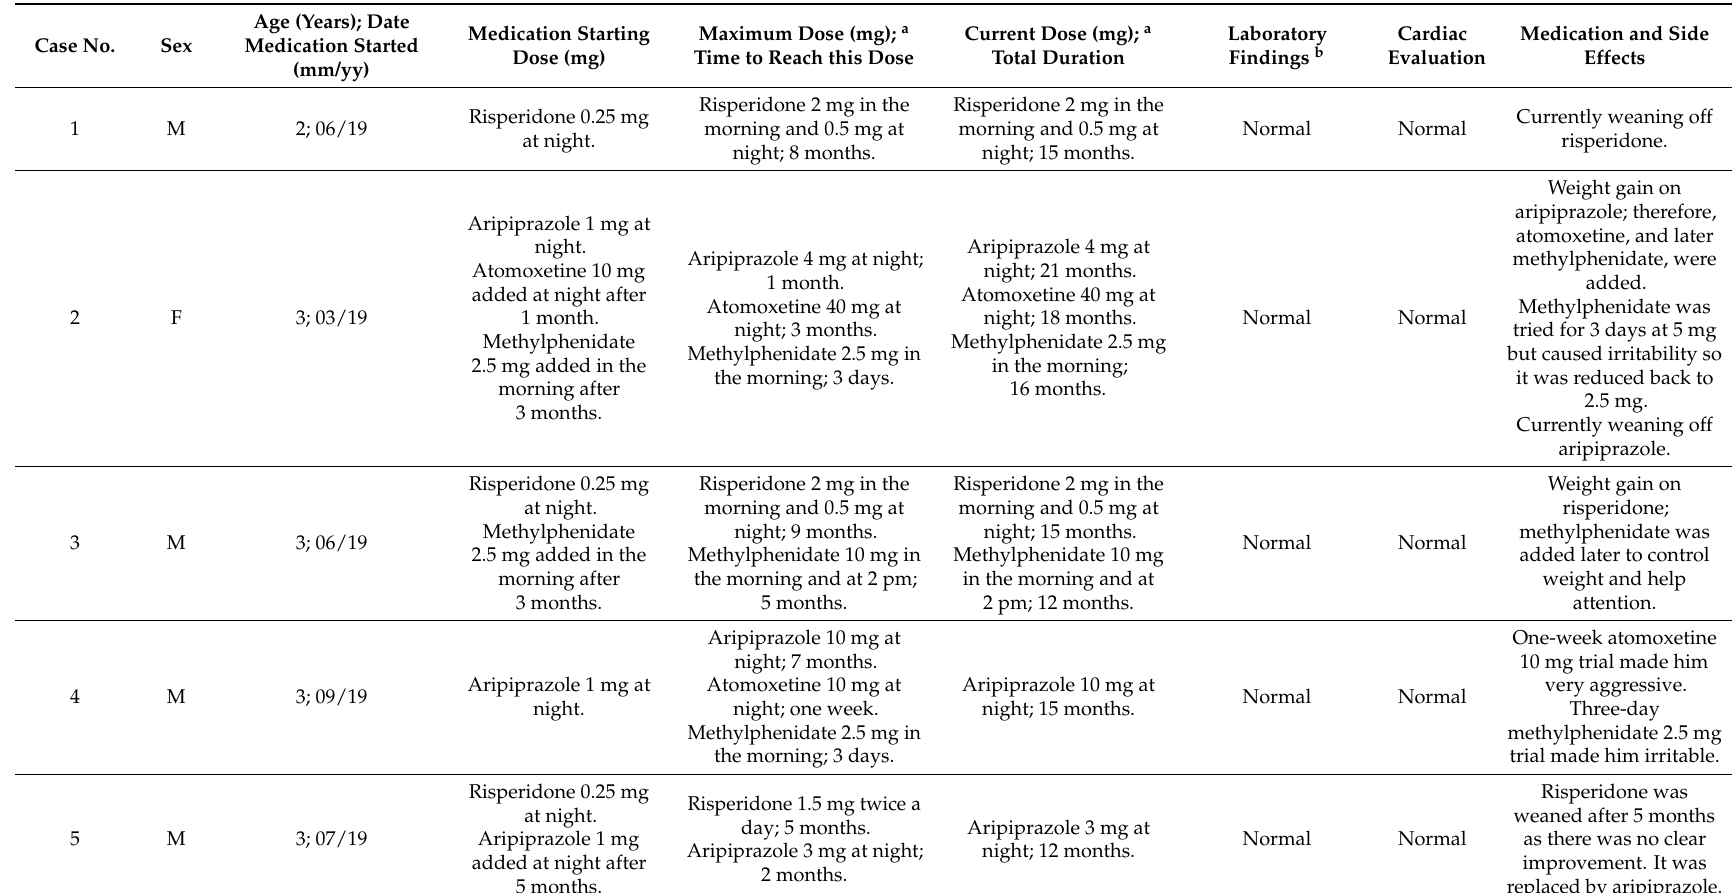
Table 1. Clinical characteristics of